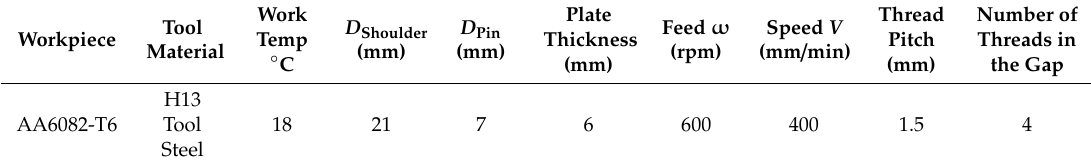
Table 2. The specification of the operation parameters for the AA6082-T6 BFSW weld sample.